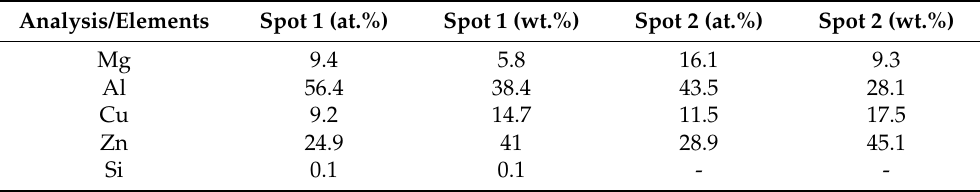
Table 7. Elemental composition of the manufactured alloy in eutectic region of sample 1M obtained by EDS. Analysis/Elements Spot 1